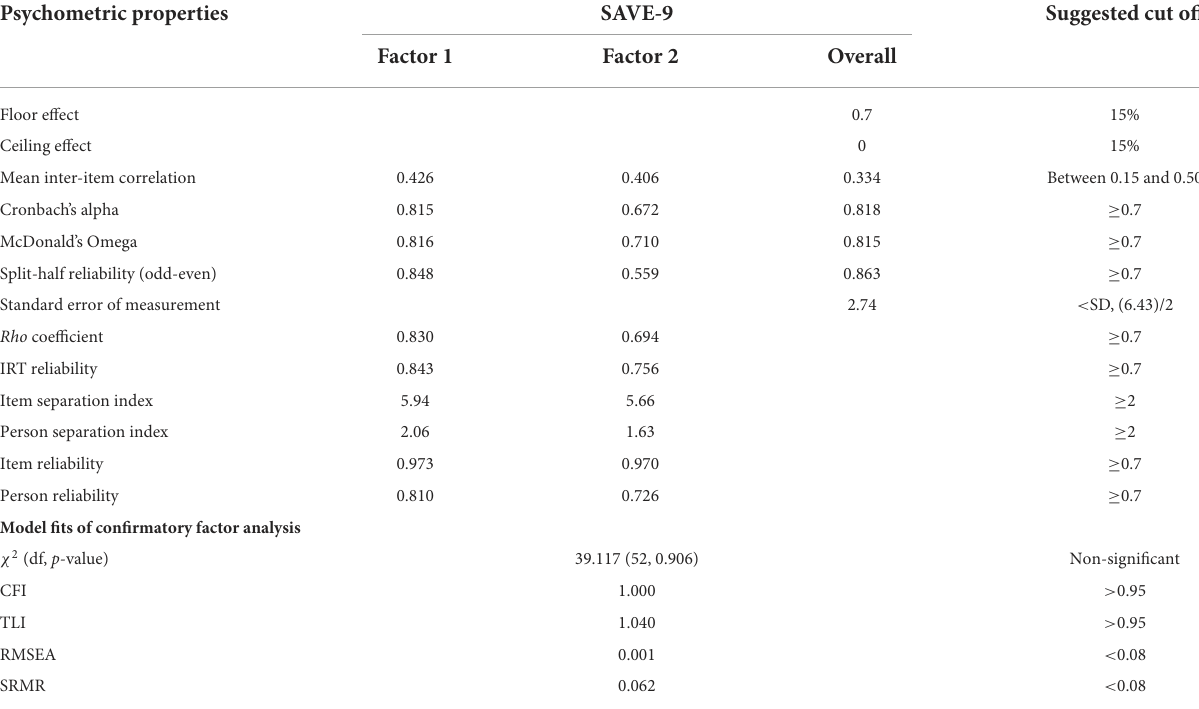
TABLE 3 Scale level psychometric properties of the SAVE-9 scale among nursing professionals working in COVID-19 inpatients wards. Psychometric